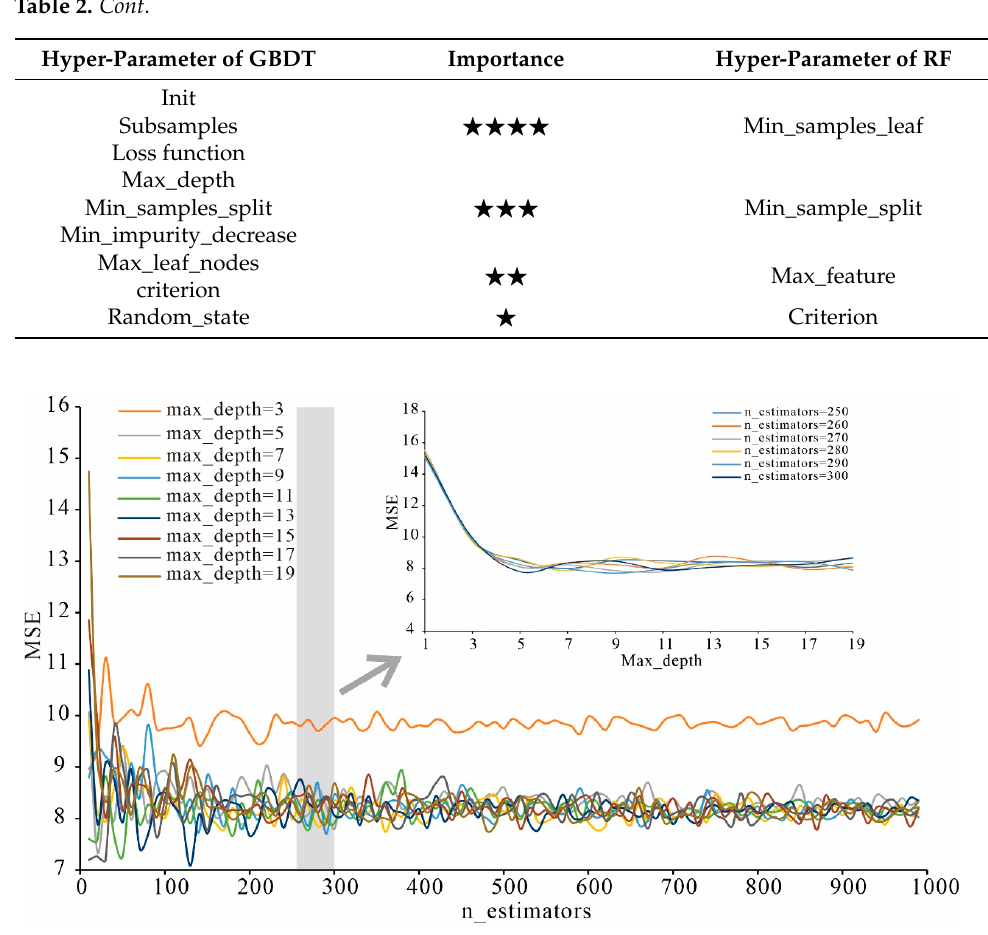
Figure 5. Manual tuning of RF model.